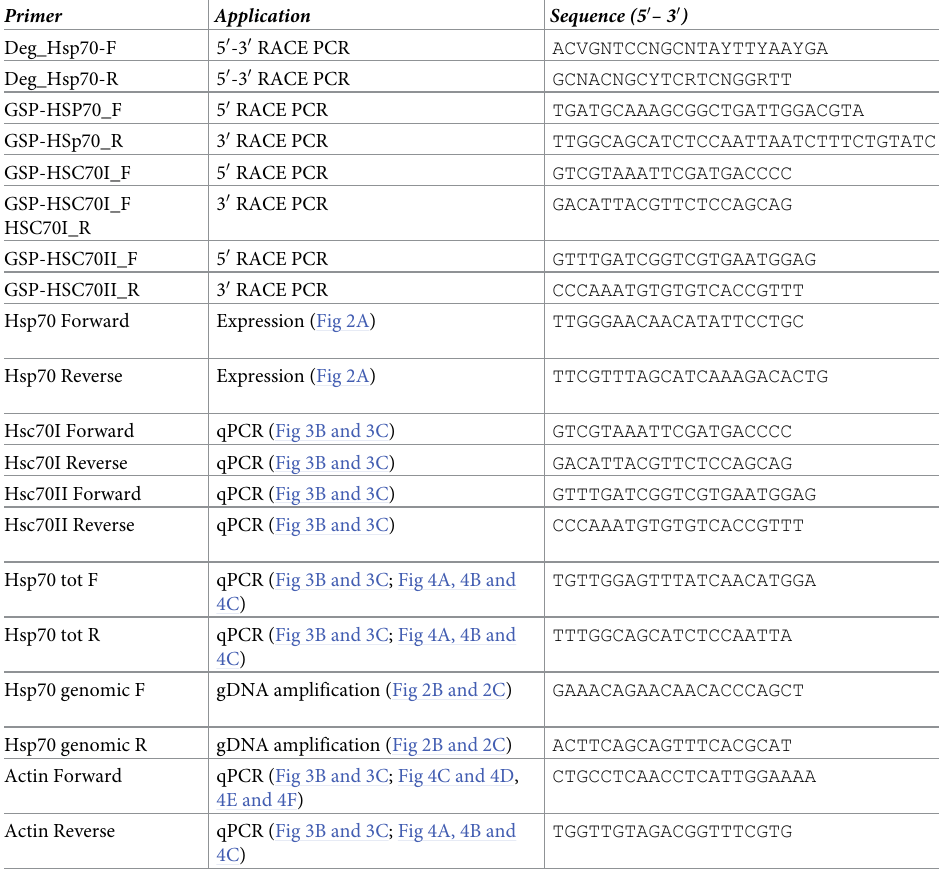
Table 1. List of primers (5 0 -3 0 ) used to amplify hsp70 with and without intron, hsc70-Isfgsgs , hsc70-II , and actin in RT-PCR